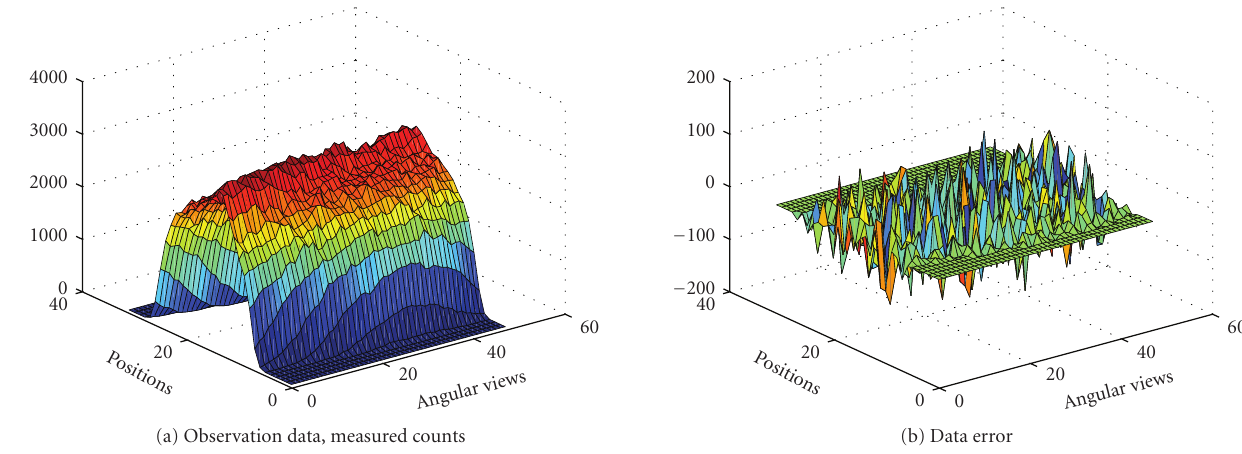
Figure 11: Sinogram data, obtained by forward projection: n = Pλ plus Poisson